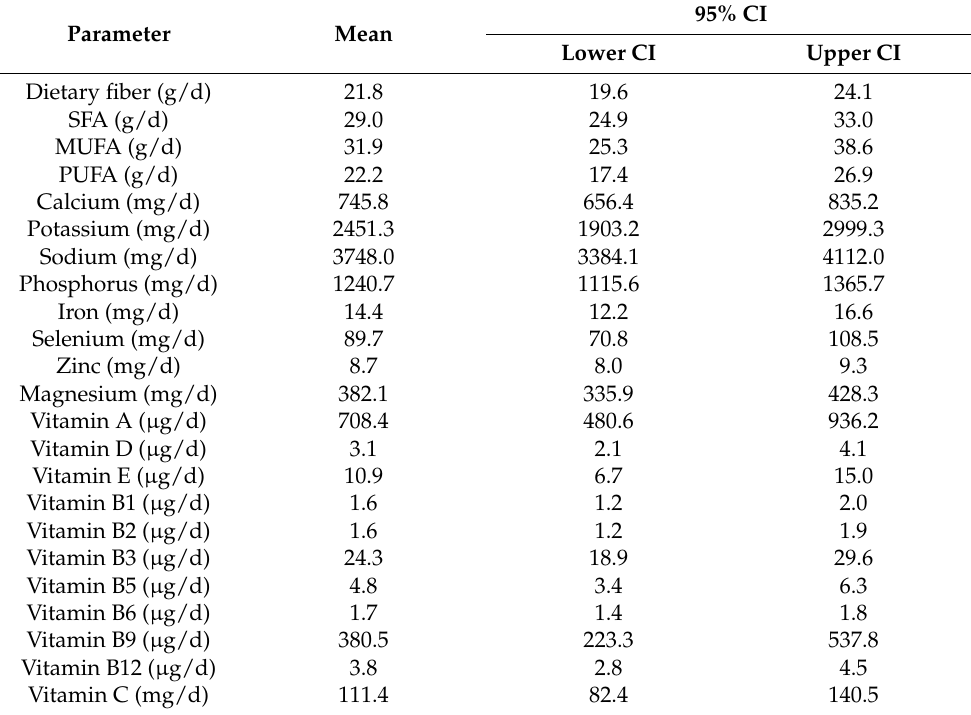
Table 4. Average daily intake (95% confidence interval) of micro- and macro-nutrient intakes of people in the countries sampled in Eastern Mediterranean